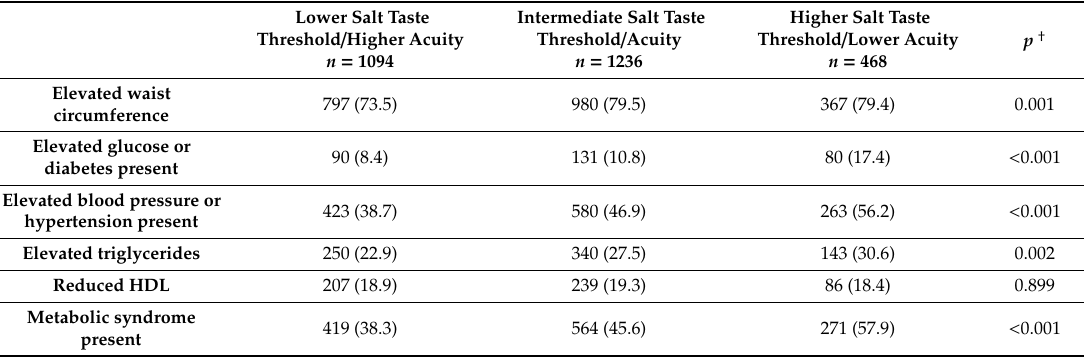
Table 3. Prevalence of metabolic syndrome components according to the salt taste recognition threshold perception, data are presented as n